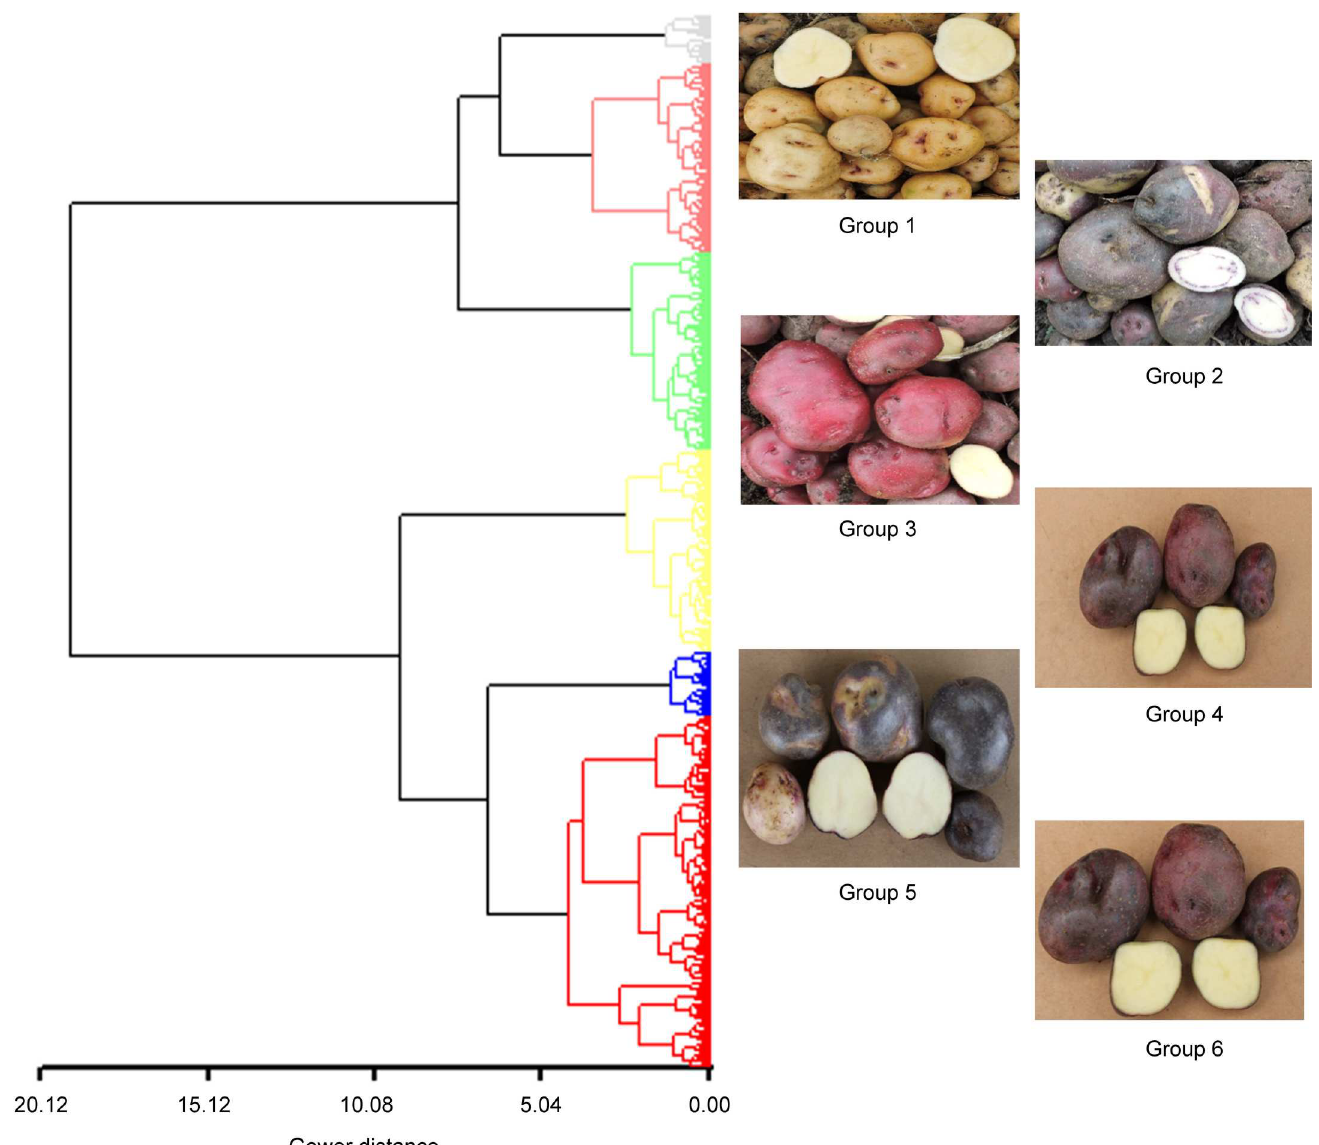
Fig 5. Dendrogram generated by the Ward method and Gower distances between 624 tetraploid accessions (population Andigena) of the Colombian Central Collection of S . tuberosum based on qualitative morphological data.